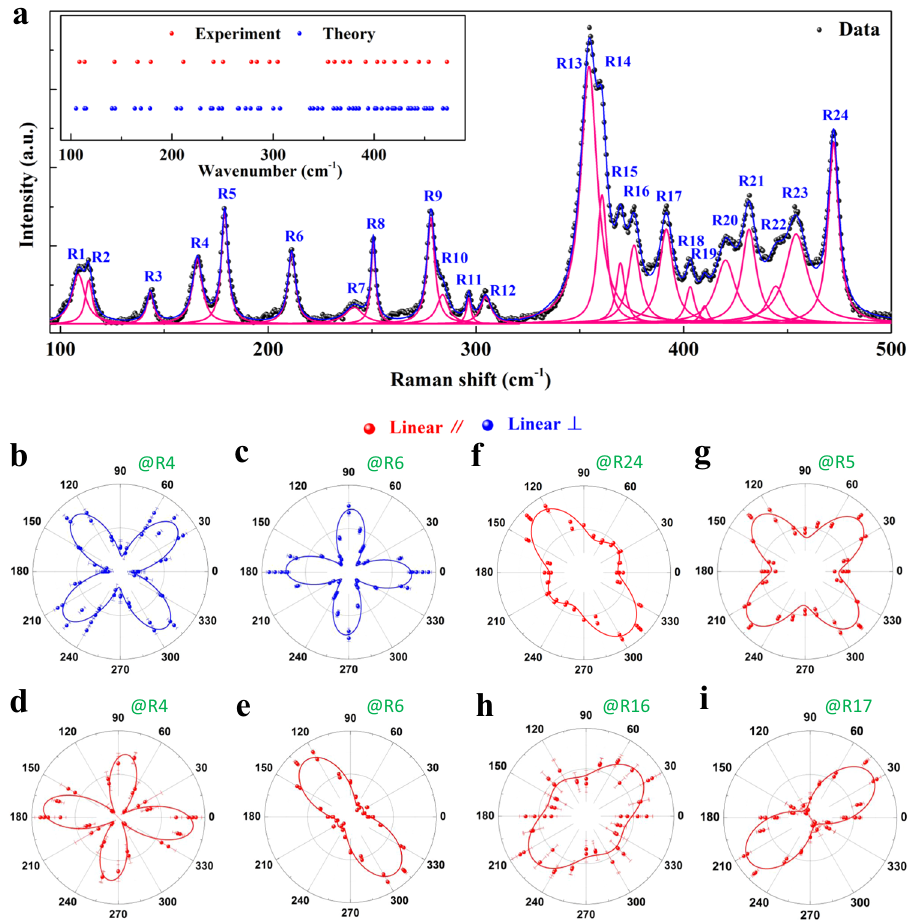
Fig. 5 Giant anisotropic lattice vibration properties in 1D vdW FRP. a Nonpolarized Raman spectra (black dots) for the exfoliated 1D vdW FRP fl ake, excited by a 2.33-eV excitation laser at room temperature. The Raman spectra of the 1D vdW FRP fl ake are fi t to a sum of Lorentzians (blue and pink curves), from which we can obtain 24 sharp phonon peaks, labeled as R1 – R24. The inset is the comparison between experimental (red) and calculated phonon energies (blue). b – i Polar plots of Raman intensity for six representative phonons as a function of polarization angle θ under copolarized (red dots) and cross-polarized (blue dots) con fi gurations. The red and blue solid lines are fi tted curves using Eqs. (2) and (3), solid lines in Fig. 5b – i and Supplementary Fig. 13, Eqs. (2) and (3) can perfectly describe the experimental data under copolarized or cross-polarized con fi gurations, respectively.